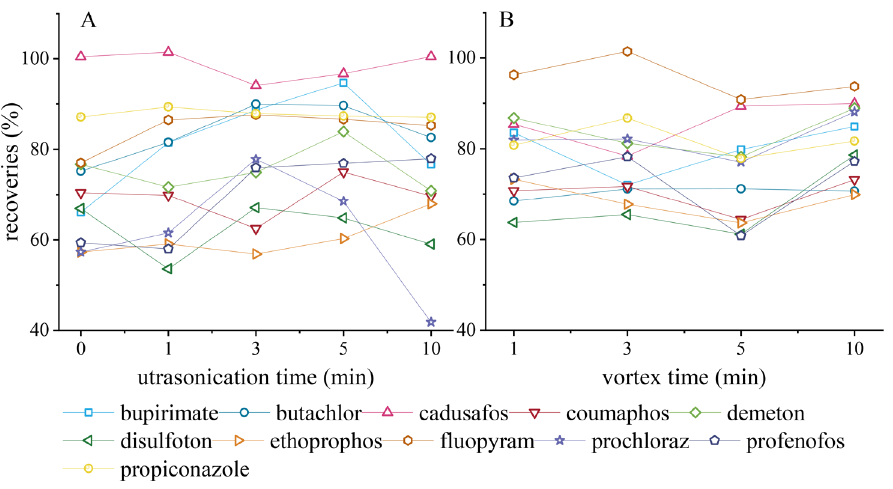
Figure 4. The desorption efficiency of ultrasonication (US) time ( A ) and vortex (VOR) time ( B